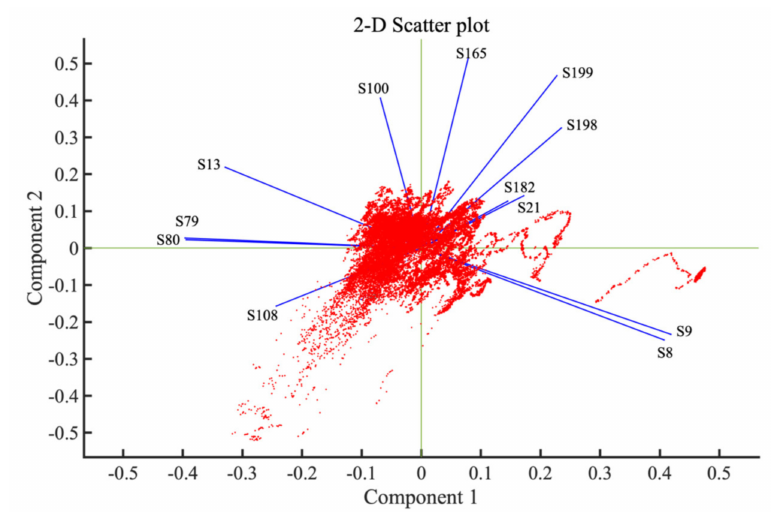
Figure 5. The percentage of explained variance for principal components.